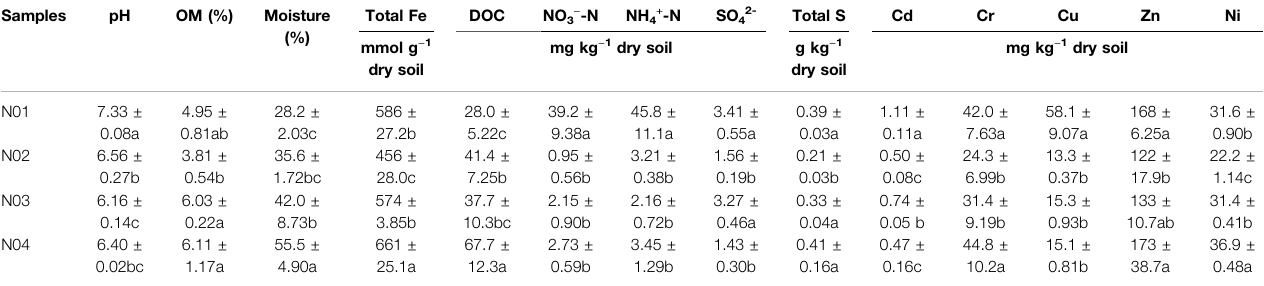
Abbreviations: DOC, dissolved organic carbon; OM, organic matter; Total S, Total sulfur.